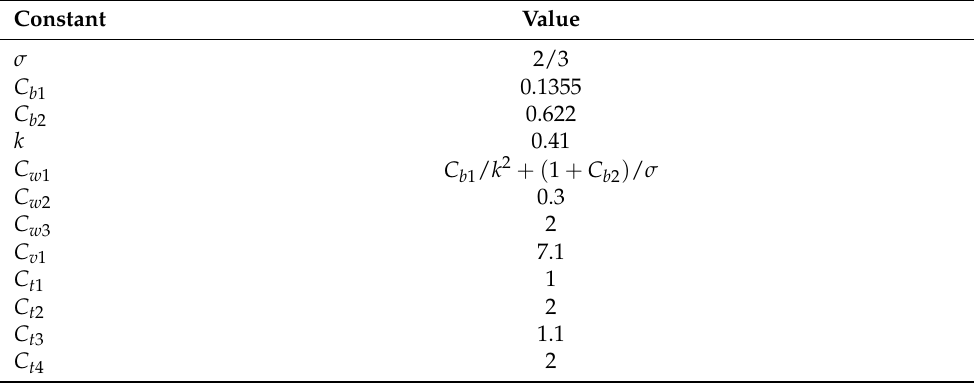
Table 4. Constants included in the turbulence